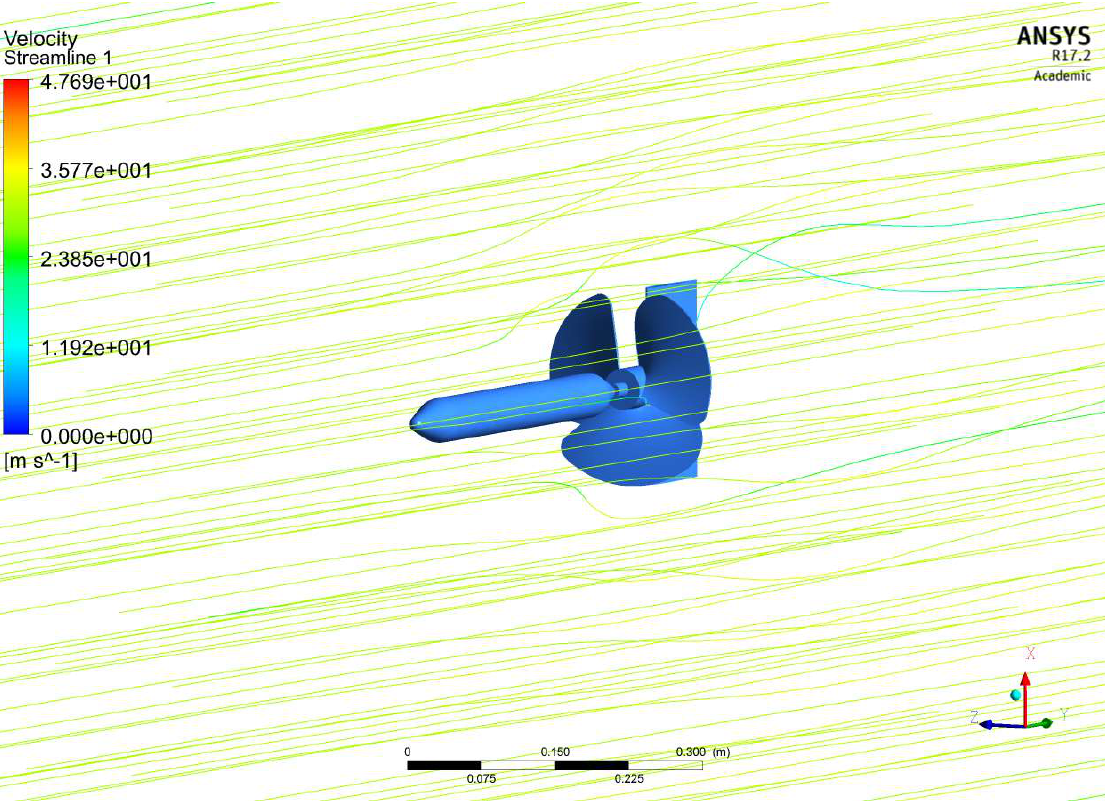
Figure 29. A systematic representations of velocity streamline over the body of US.